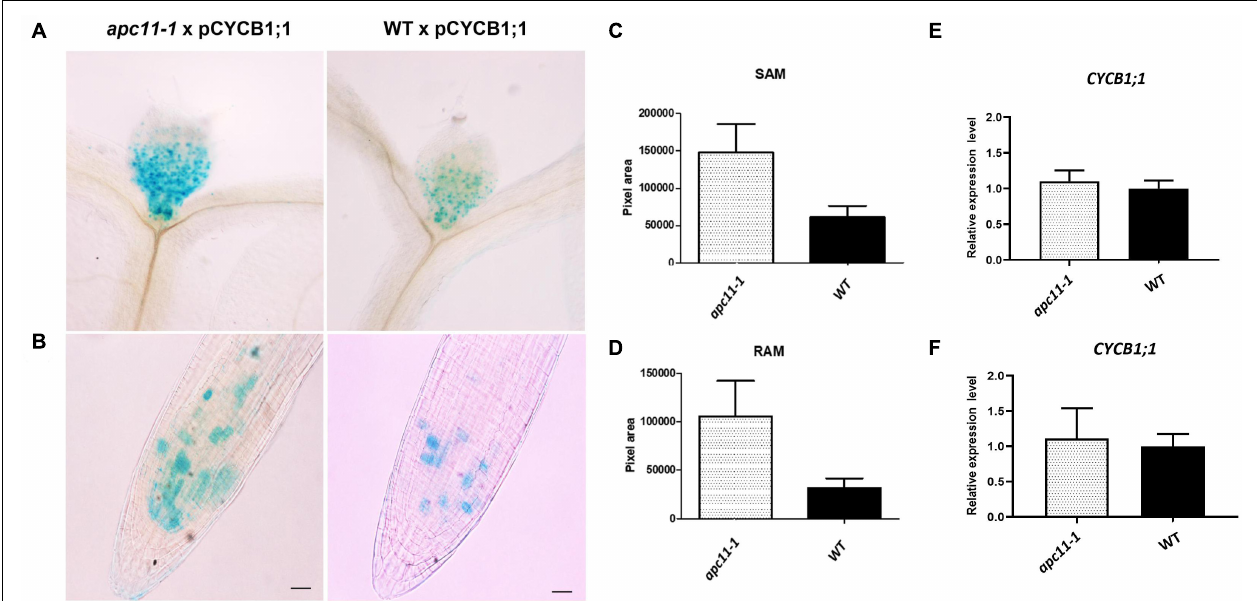
FIGURE 6 | Meristematic loss of function of APC in apc11-1 viewed through p CYCB1;1: D–box– β -glucuronidase (GUS) crosses. Anaphase–promoting complex (APC) activity in mutant ( apc11 − / − ) plants crossed with p CYCB1;1 :D–box–GUS construct. (A) Picture of the p CYCB1;1 :D–box–GUS staining on leaves 1 and 2 at 8 DAS of mutant and WT lines. (B) Picture of the p CYCB1;1 :D–box–GUS staining on roots at 8 DAS of mutant and WT lines. (C) Measurement graph of GUS intensity on leaves from the mutant and WT lines; n = 15, P < 0.0001. (D) Measurement graph of GUS intensity on roots from the mutant and WT lines; n = 15, P < 0.001. (E) Quantitative RT-PCR transcript analysis of CYCB1;1 gene expression marker in apc11-1 and WT from leaves at 8 DAS. All values were normalized against the expression level of the housekeeping genes and expression compared to the expression data in the WT control. Data are means ± SD ( n = 3). (F) Quantitative RT-PCR transcript analysis of CYCB1;1 gene expression marker in apc11-1 and WT from roots at 8 DAS. All values were normalized against the expression level of the housekeeping genes and expression compared to the expression data in the WT control. Data are means SD ( n =